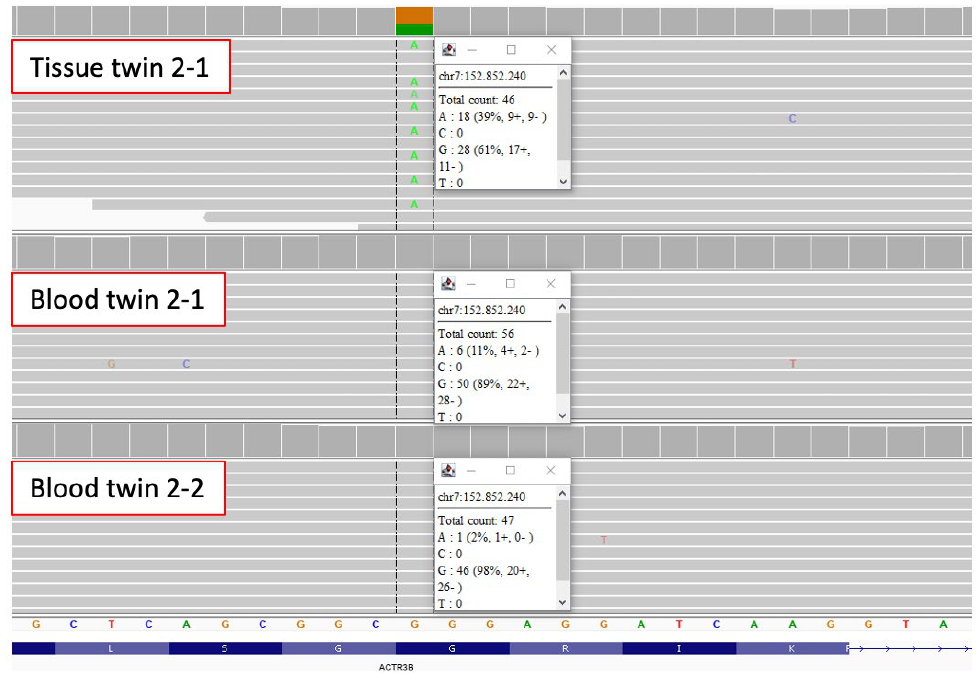
Figure 1. Mosaic missense variant in ACTR3B identified in blood and tissue of twin 2-1. IGV reads show that the variant c.1066G>A, p.Gly356Arg in ACTR3B has an allele frequency of about 39% in uterine tissue and an allele frequency of about 11% in blood of the affected twin 2-1, while blood of twin 2-2 only has 1 supporting read.